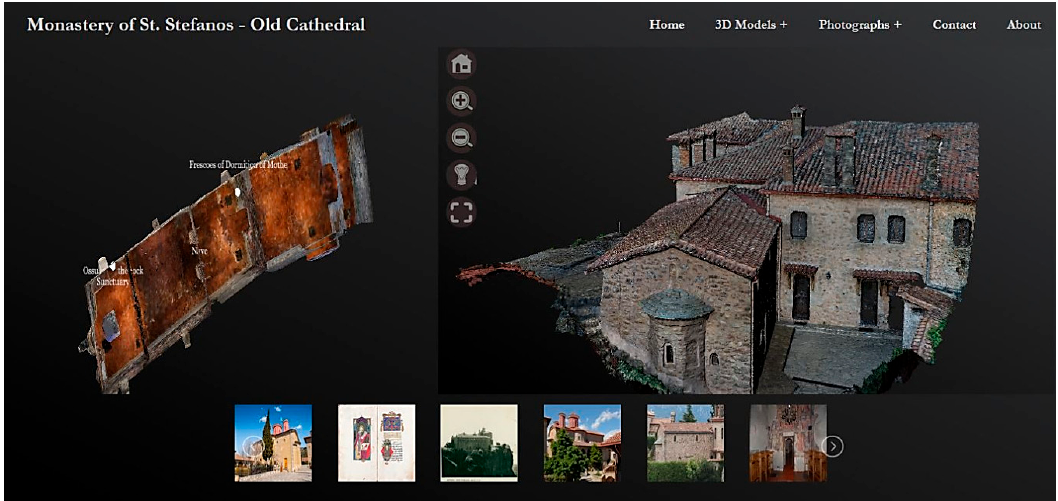
Figure 9. The third page of the 3D platform that hosts the documentation data of the old catholikon of St. Stephen monastery.